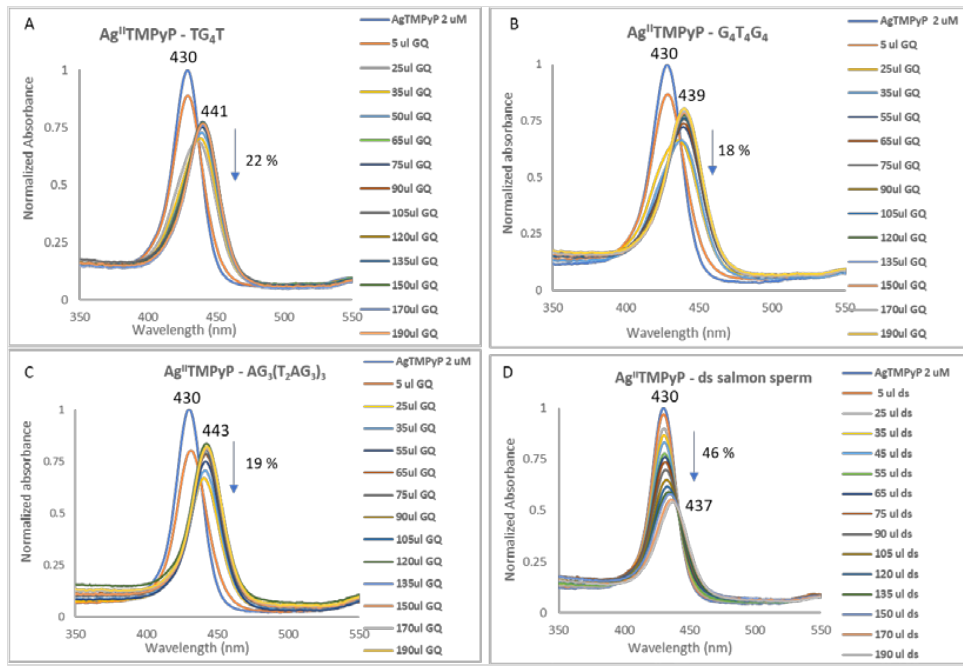
Figure 16. UV-Vis spectra (350–650 nm) obtained for Ag II TMPyP and ( A ) tetramolecular GQ, ( B ) bimolecular GQ, ( C ) unimolecular GQ and ( D ) salmon sperm double-stranded DNA. DNA structures were prepared in 20 mM PBS buffer with 100 mM KCl.